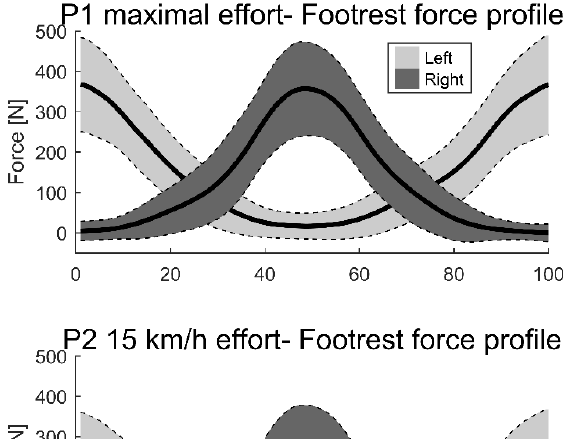
Table 2. The variables averaged for 25 participants.